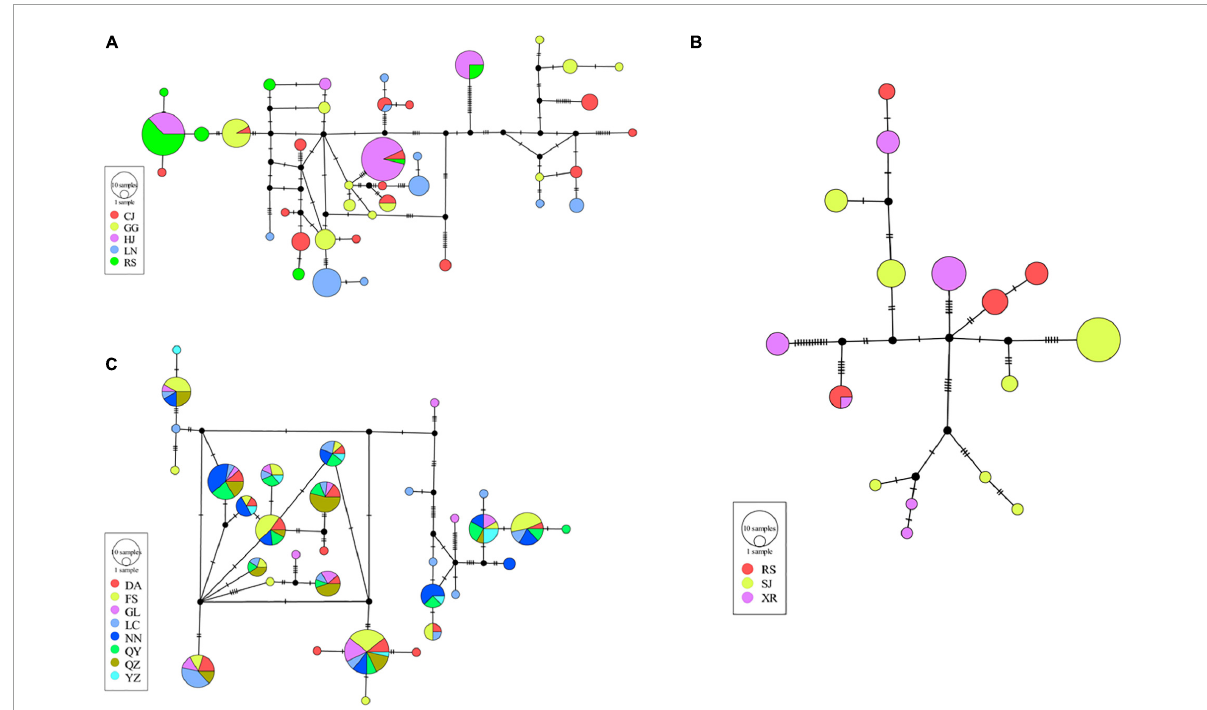
FIGURE4 Haplotype network of PF-carp. Panels (A–C) represents Daotian carp (DTL), Jinbian carp (JBL), and Wu carp (WL), respectively. Cycle size is roughly proportional to the haplotype frequency. Location abbreviations refer to Figure 1 and Supplementary Table 1